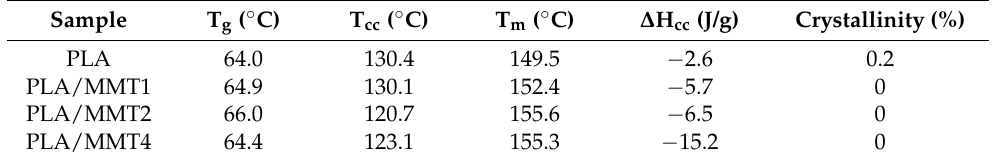
Table 6. Characteristic thermal transition temperatures of PLA and PLA/MMT filaments.